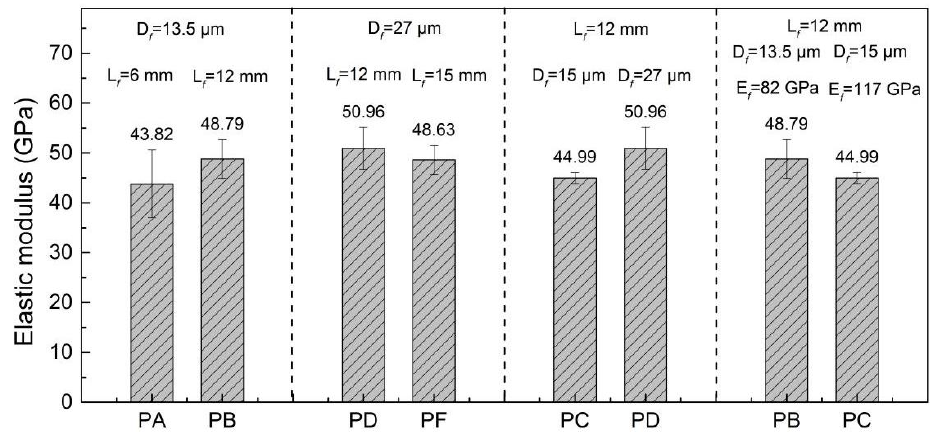
Figure 8. Elastic modulus of PE fiber-reinforced Figure 8 . Elastic modulus of PE fiber-reinforced UHPC. Table 5 . Uniaxial tensile parameters of UHPC with PE fiber.